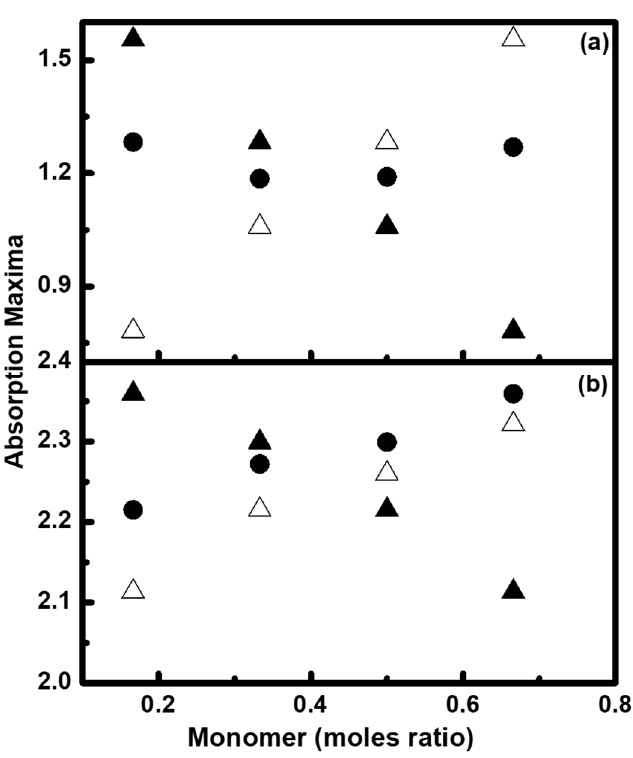
Figure 6. Absorption maxima of fluorescent dispersions as a function of moles ratio of BZMA ( ∆ ), MMA ( ▲ ), and HPMA ( • ) for ( a ) BR and ( b ) BV.